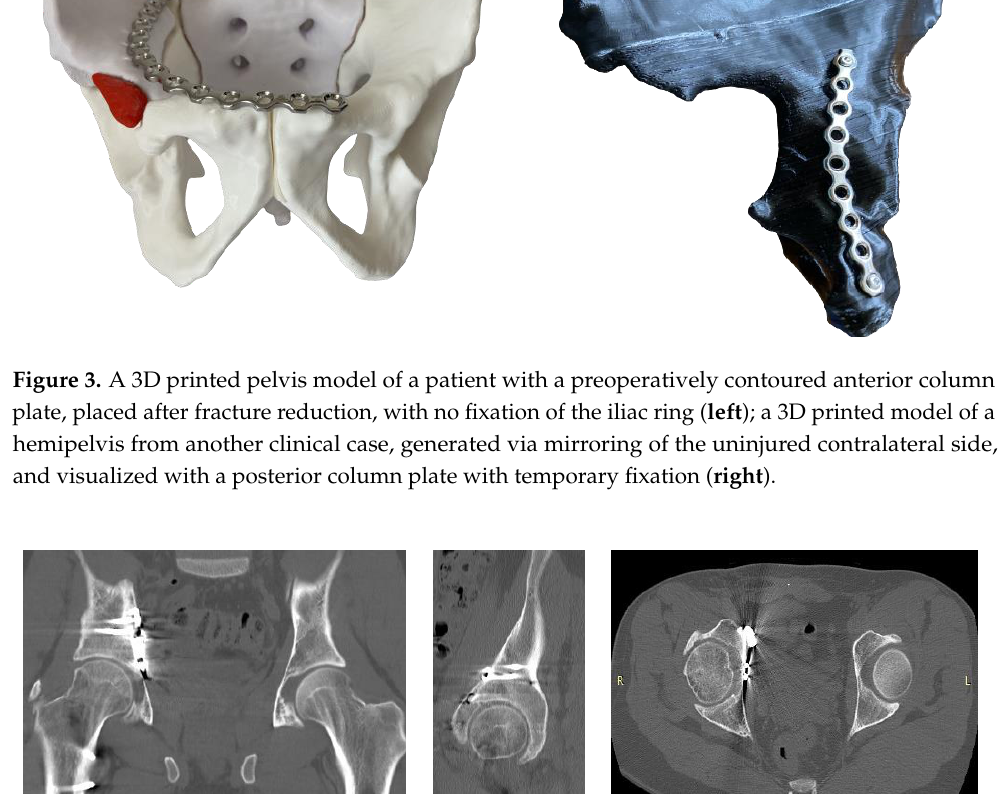
Figure 4. Postoperative CT scan of a clinical case exhibited in coronal ( left ), sagittal ( middle ), and axial ( right ) views and demonstrating excellent anatomical reduction.